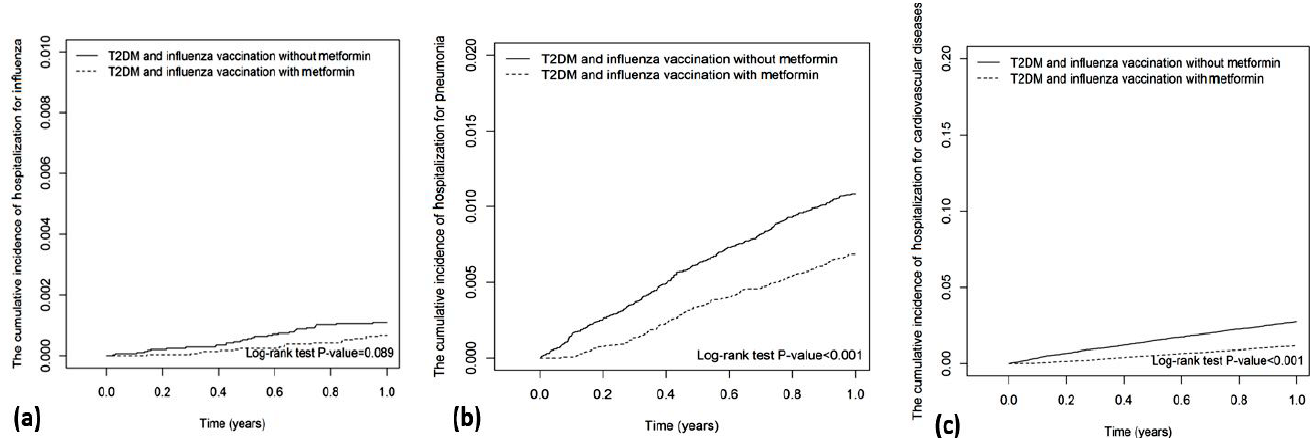
Figure 2. Cumulative incidences of hospitalization for ( a ) influenza, ( b ) pneumonia, and ( c ) cardio- vascular disease.